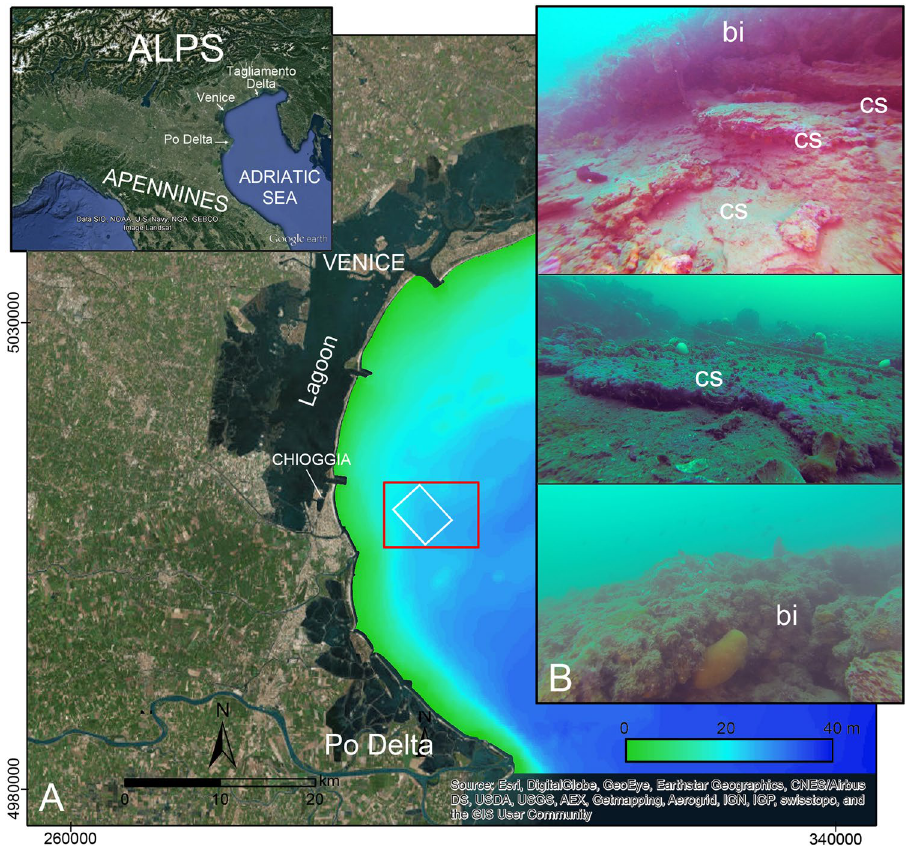
Figure 1. ( A ) Location of the study area (red rectangle) in the northern Po River Delta and Venice coastland (UTM 33N WGS84). White rectangle shows the area of the shaded relief map of Fig. 2. Base maps are Google Earth and Esri, DigitalGlobe, GeoEye, Earthstar Geographics, CNES/Airbus DS, USDA, USGS, AEX, Getmapping, Aerogrid, IGN, IGP, swisstopo, and the GIS User Community; bathymetric data are from EMODnet Bathymetry Consortium, http://doi.org/10.12770/c7b53704-999d-4721-b1a3-04ec60c87238 43 . Images are composed in ESRI ArcMAP 9.3. ( B ) Underwater photographs of rocky buildups (tegnùe): cemented sand layers (cs) at the base of the bioconstructions (bi) are shown in ( B